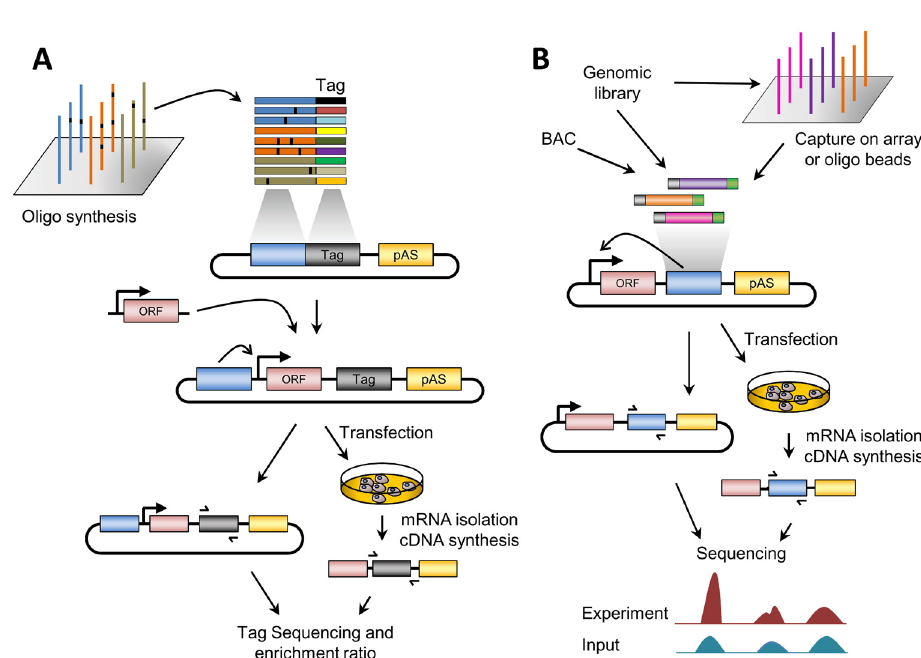
Figure 1. Principle of high-throughput assays for enhancer activity. ( A ) Overview of massively parallel reporter assay (MPRA). The test sequences (wild-type, variants, etc.) are generally synthesized in silico by massive oligonucleotide synthesis with unique barcode tags and cloned into the plasmid backbone. Tags can be synthesized along with the test sequences or added after synthesis by polymerase chain reaction (PCR) amplification. A basal promoter and a reporter open reading frame (ORF) are inserted between the tested element and tag sequences. The reporter library is then transfected into cultured cells. Subsequently, mRNA is isolated and cDNA synthesized. The tags are sequenced before (plasmid library pool, for normalization) and after the transfection. The difference in the enrichment of each barcode is proportional to the enhancer activity of the test sequence. In the case of post-synthesis addition of barcodes, an additional sequencing step is required at the first cloning step. ( B ) Overview of self-transcribing active regulatory region sequencing (STARR-Seq). A genomic or bacterial artificial chromosome (BAC) library is cloned in the reporter plasmid, downstream of the ORF and upstream of the polyadenylation site (pAS). Alternatively, the regions of interest might be enriched by a capture approach. The reporter library is transfected into cultured cells. Subsequently, mRNA is isolated and cDNA synthesized. The cloned regions are sequenced from the plasmid library pool (input) and the cDNA. Differences in the enrichment with respect to the input are proportional to the enhancer activity. In both panels, the effect of the enhancer on the basal promoter is indicated by an